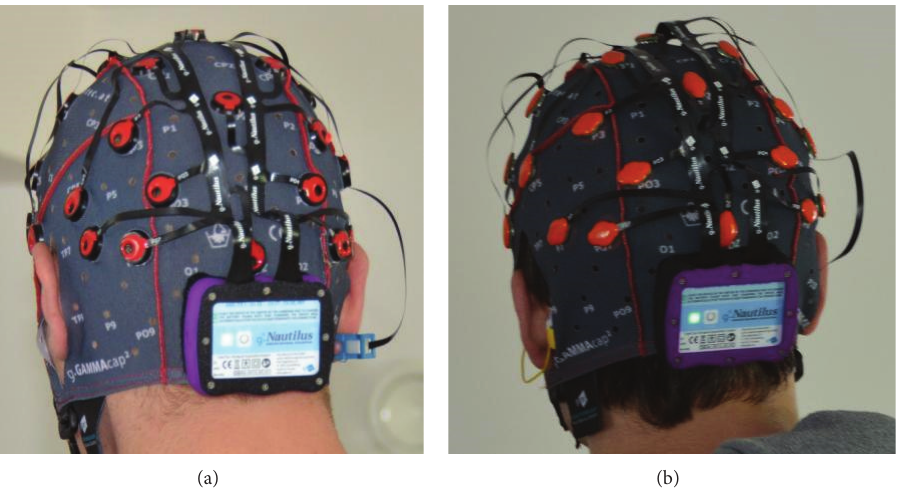
Figure 5: g.Nautilus headset with gel based (a) and dry electrodes